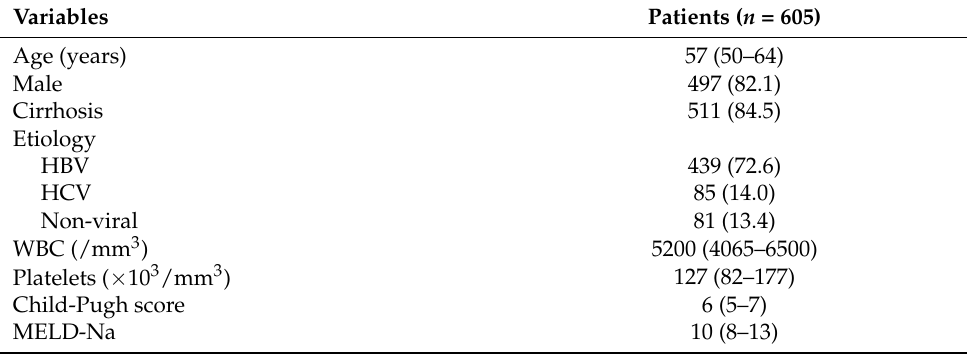
Table 1. Baseline characteristics of the study